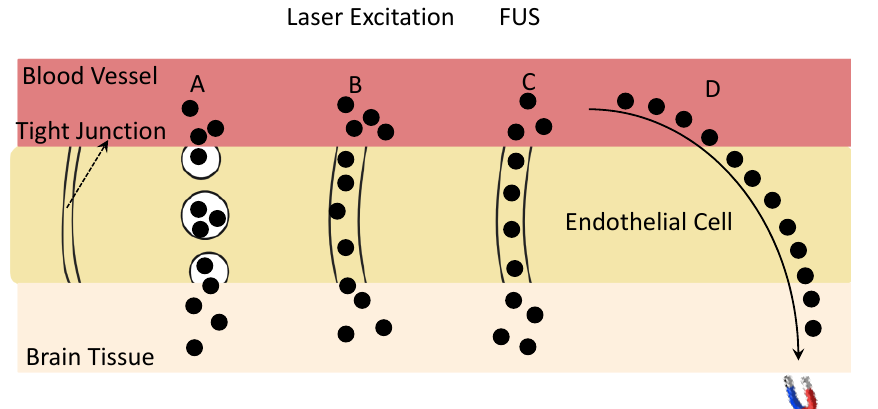
Figure 4. Schematic illustration of BBB-crossing pathways of magneto-plasmonic NPs assisted by surface functionalization and different external stimulations: ( A ) receptor-mediated transcytosis enhances the uptake of NPs functionalized with specific ligands; ( B ) paracellular transport of NPs by disrupting the tight-junction system under the irradiation of laser light; ( C ) paracellular transport of NPs by disrupting the tight-junction system under the exposure to FUS; ( D ) targeted passage of NPs through BBB directed by MF.